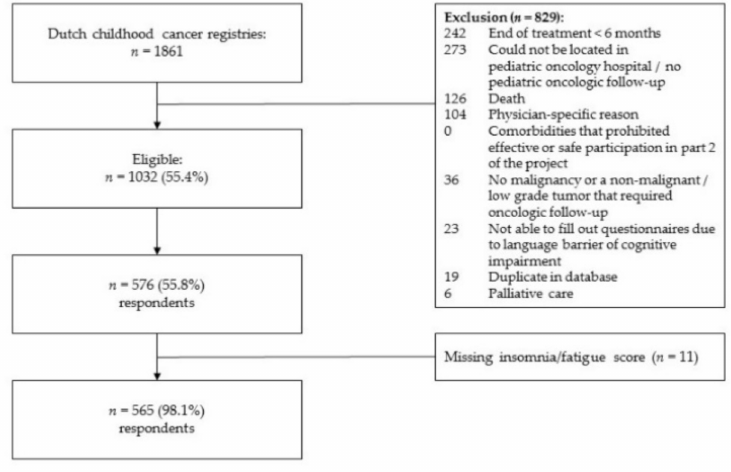
Figure 1. Flowchart of study inclusion.